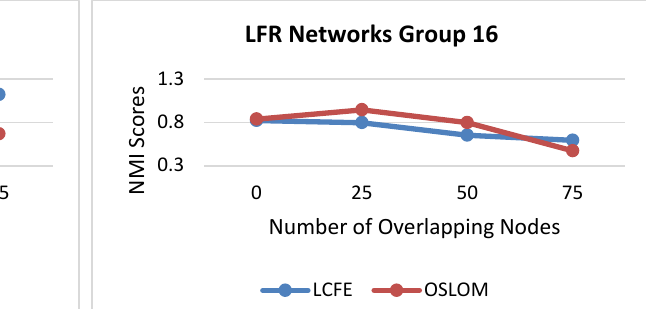
Fig. 17. NMI score comparison for LCFE and OSLOM for fifteenth group of LFR Networks with number of overlapping nodes ranging from 0 to 75